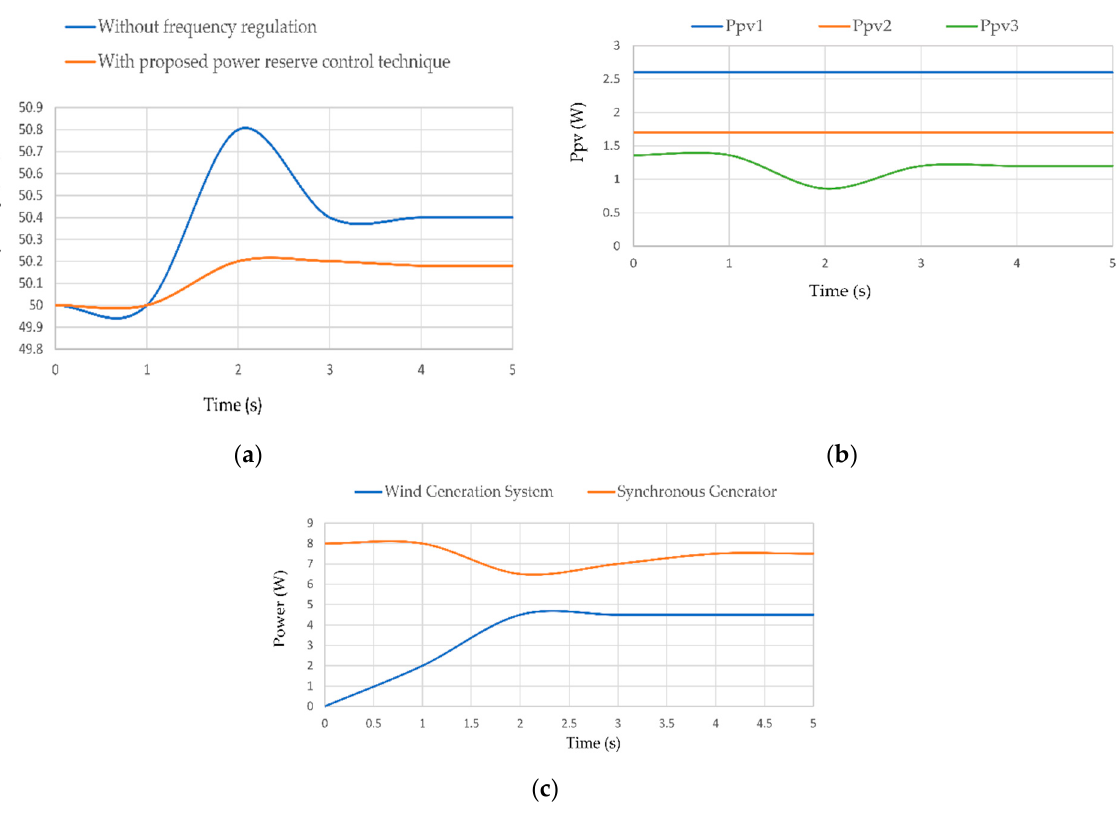
Figure 11. System output waveforms when the load is incremented by 0.5 MW: ( a ) Frequency; ( b ) PV output power; ( c ) output power of wind generation system and synchronous generator.